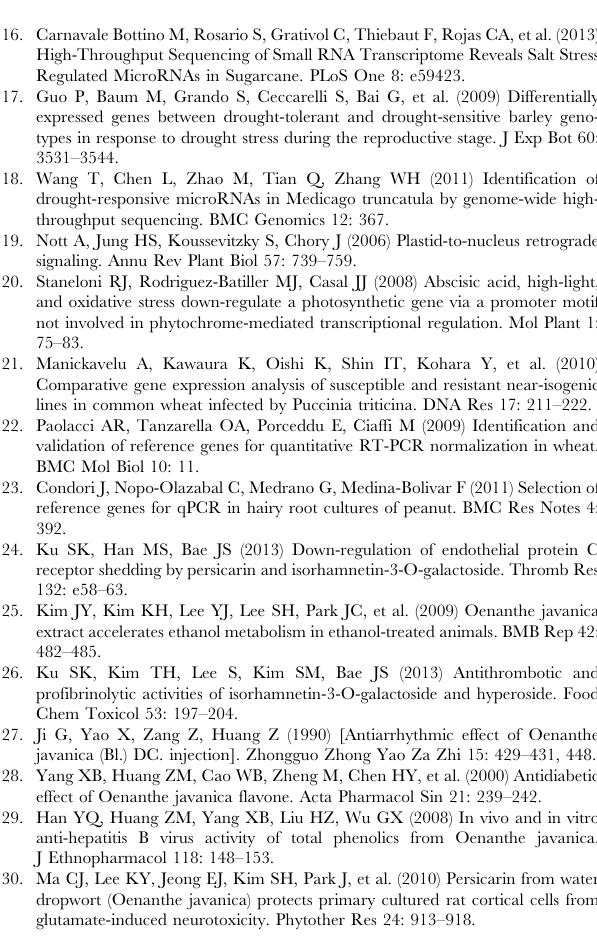
Table S3 Data statistics of Cq values of candidate reference